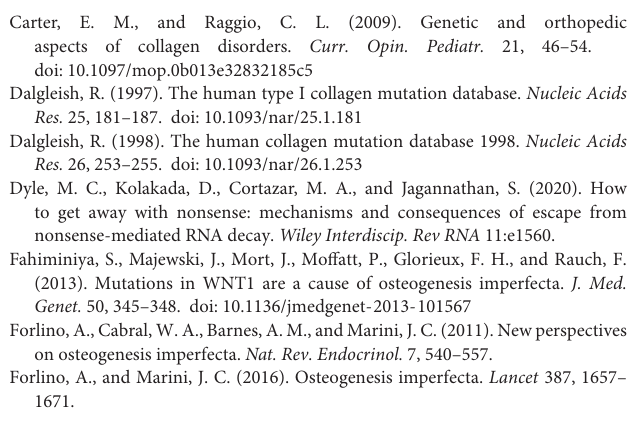
Supplementary Figure 1 | Co-occurring mutation in WNT1 in the OI patients. (A) Positions of WNT1 variants: TM, transmembrane region. (B) Sanger sequencing confirmed WNT1 mutation. (C) X-ray films showed marked osteoporosis and thinning of vertebral bodies. (D) IGV view of shashimi plot showing reads with WNT1 c.677C > T (p.S226L) from RNA sequencing of PBMCs of P6. Supplementary Figure 2 | Mutation in COL2A1 in the SEDC patients. (A) Positions of COL2A1 (NP_001835.3) variants: VWC, von Willebrand factor type C domain; (C) Collagen triple helix repeat (20 copies); COLFI, Fibrillar collagen C-terminal domain. (B–D) Sanger sequencing confirmed de novo